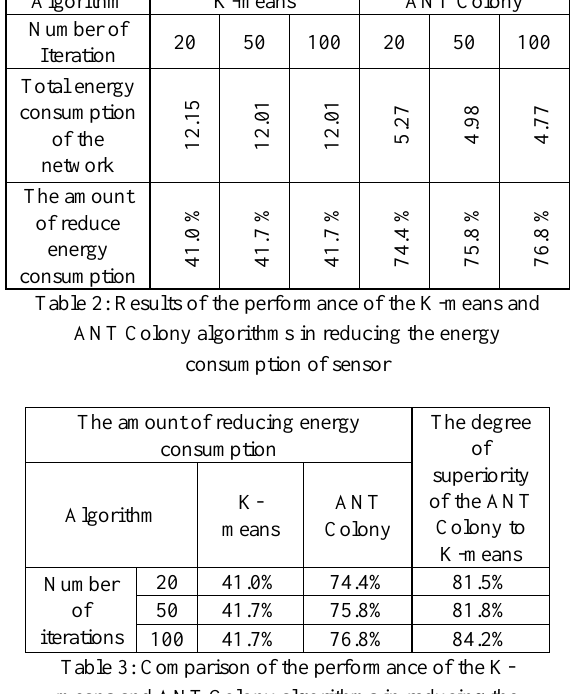
Table 3: Comparison of the performance of the K- means and ANT Colony algorithms in reducing the energy consumption of sensors in equal number of